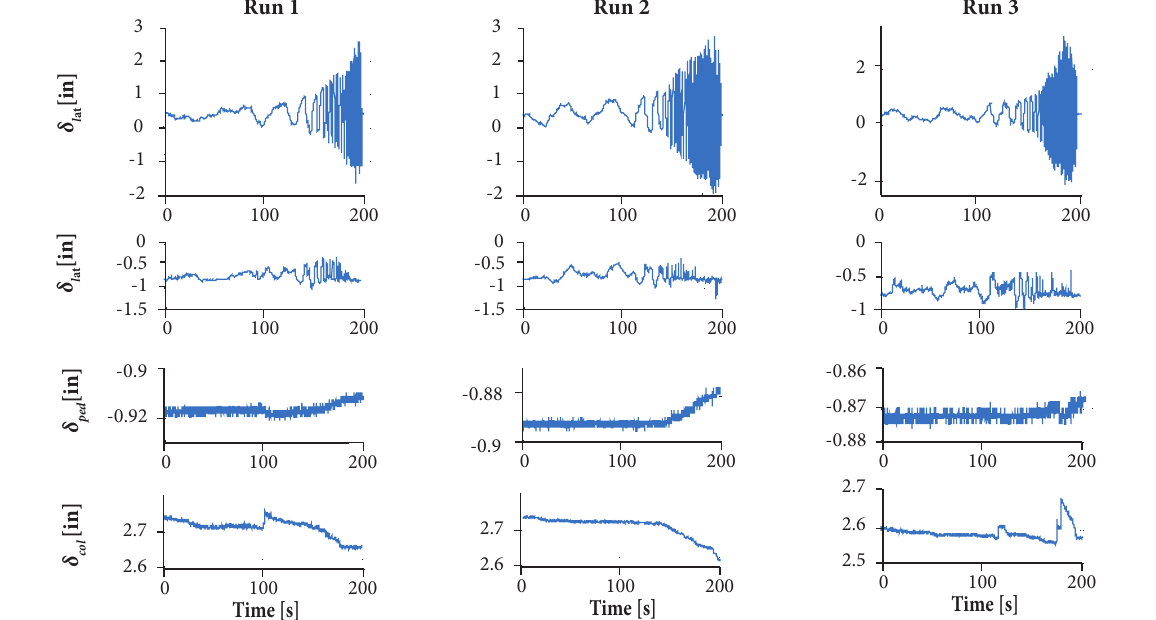
Figure 4. Lateral cyclic control inputs — level flight (80